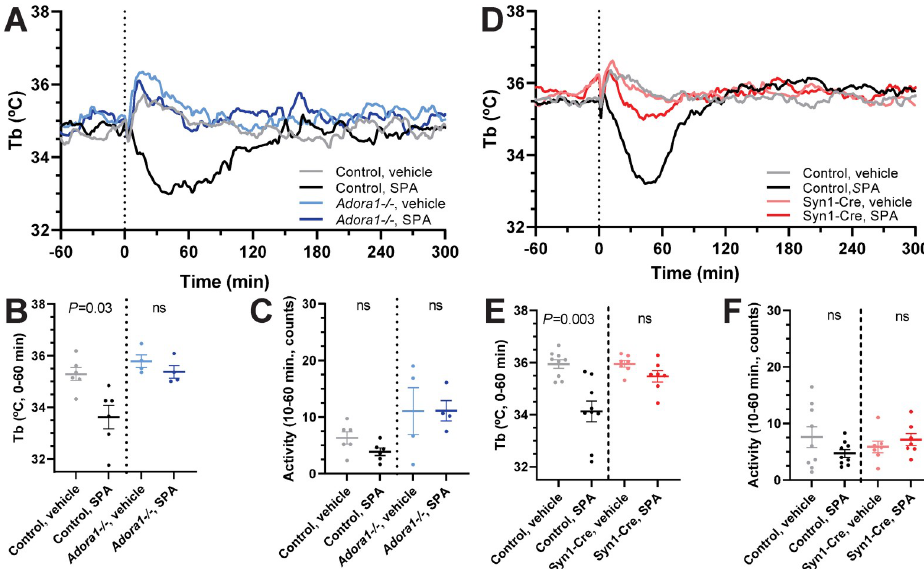
Fig 3. SPA-induced hypothermia is lost in global Adora1 -/- and attenuated in Adora1 fl ;Syn1-Cre mice. (A-C) Tb and physical activity response to SPA (1 mg/kg, i.p.) in control (n = 6) and Adora1 -/- (n = 4) mice. (D-F) Tb and physical activity response to SPA (1 mg/kg, i.p.) in Adora1 fl (control, n = 9) and Adora1 fl ;Syn1-Cre (Syn1-Cre, n = 7) mice. Data are mean ± SEM (SEM is omitted for visual clarity in A and D). P values were calculated by paired t -test comparing drug vs vehicle within